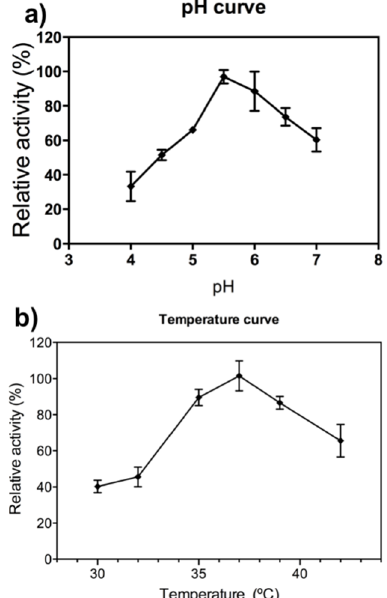
Figure 1. Biochemical characterization of recombinant FcXTH2 protein. ( a ) The pH dependence curve of the relative XEH activity of FcXTH2, and ( b ) temperature dependence. XEH activity was assayed as Arnal et al. (2017) [42] and expressed as percentage of maximum activity ± SE of four replicates. The kinetic properties of the purified recombinant FcXTH2 enzyme were studied and the principal parameters are showed in the Table 2. K M and V max values were obtained from Michaelis−Menten saturation curves, and values calculated from nonlinear least-squares data fitting (NLSF) in GraphPad Prism 6. With values of 0.029 mg mL −1 and a 4.1 × 10 5 μg −1 mL −1 s −1 to K M and V max respectively (Table 2). Table 2. Kinetic parameters of purified FcXTH2 protein. XEH activity was assayed as Arnal et al. (2017) [42].